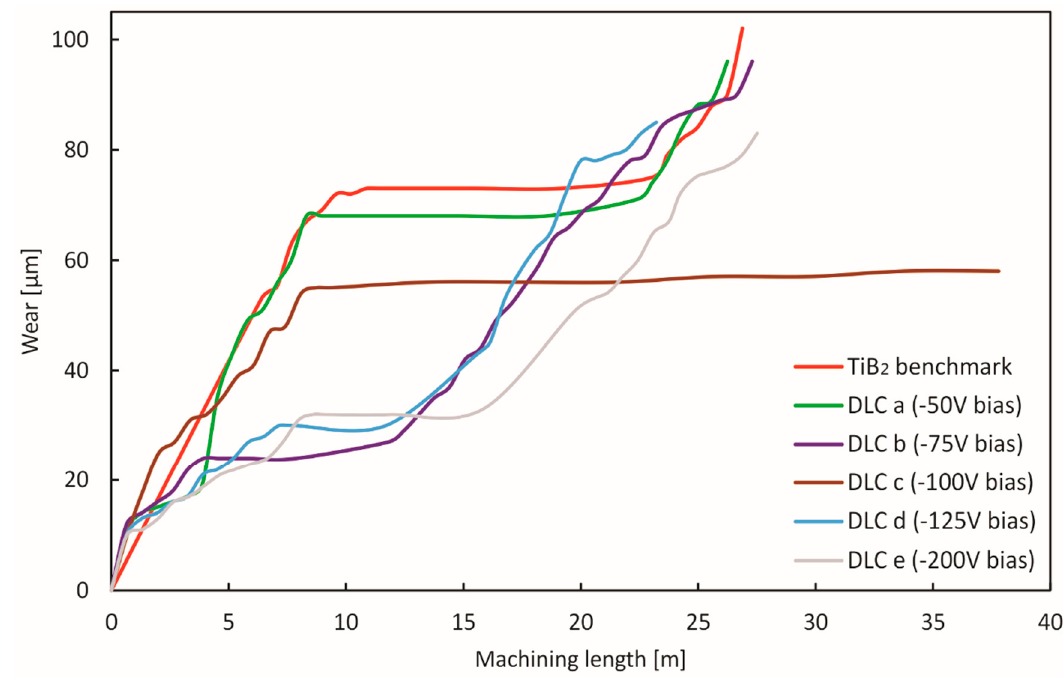
Figure 8. Tool wear curves of KC410M milling inserts with DLC coatings (cutting parameters: V c : 500 m/min, a p = 10 mm, f t : 0.05